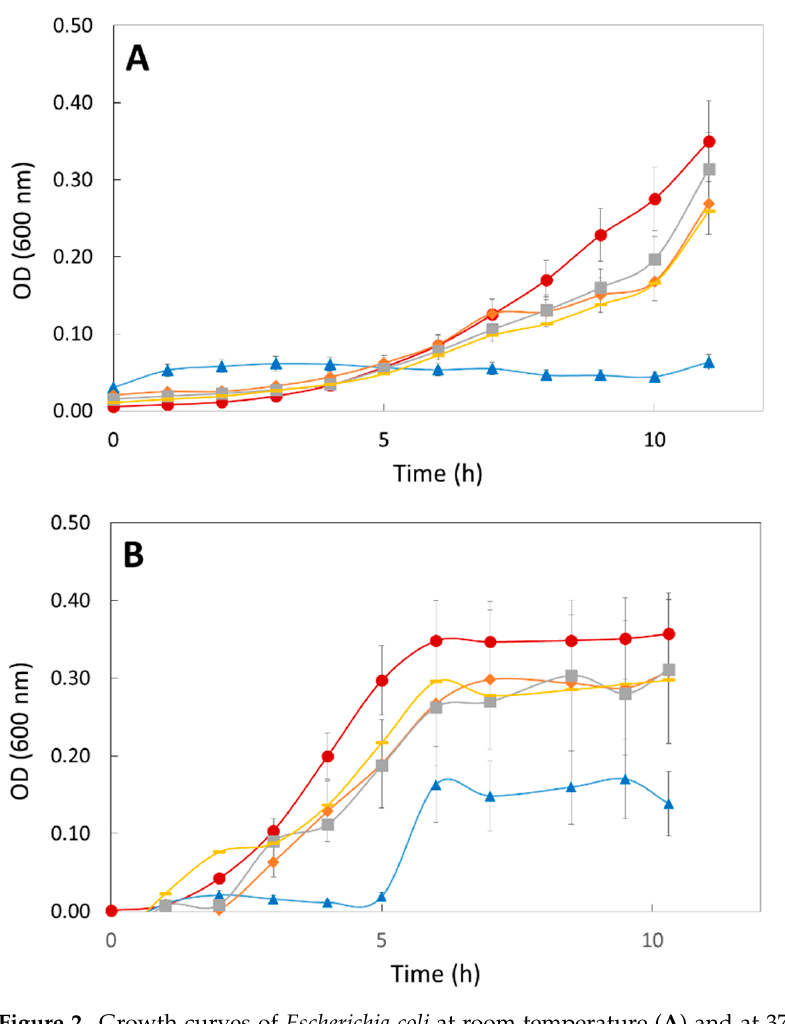
Figure 2. Growth curves of Escherichia coli at room temperature ( A ) and at 37 ◦ C ( B ): • no films;